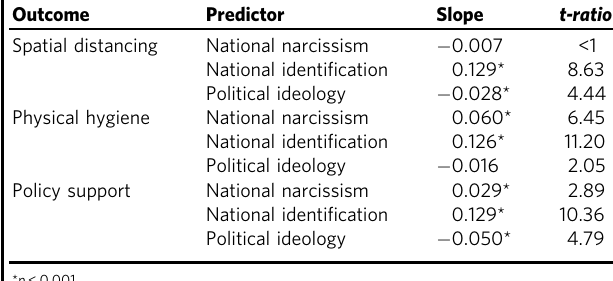
Table 2 Relationships between outcomes and predictors (including the slope and t-ratio of each relationship). National identi fi cation was the strongest predictor of all three COVID-19 public health support